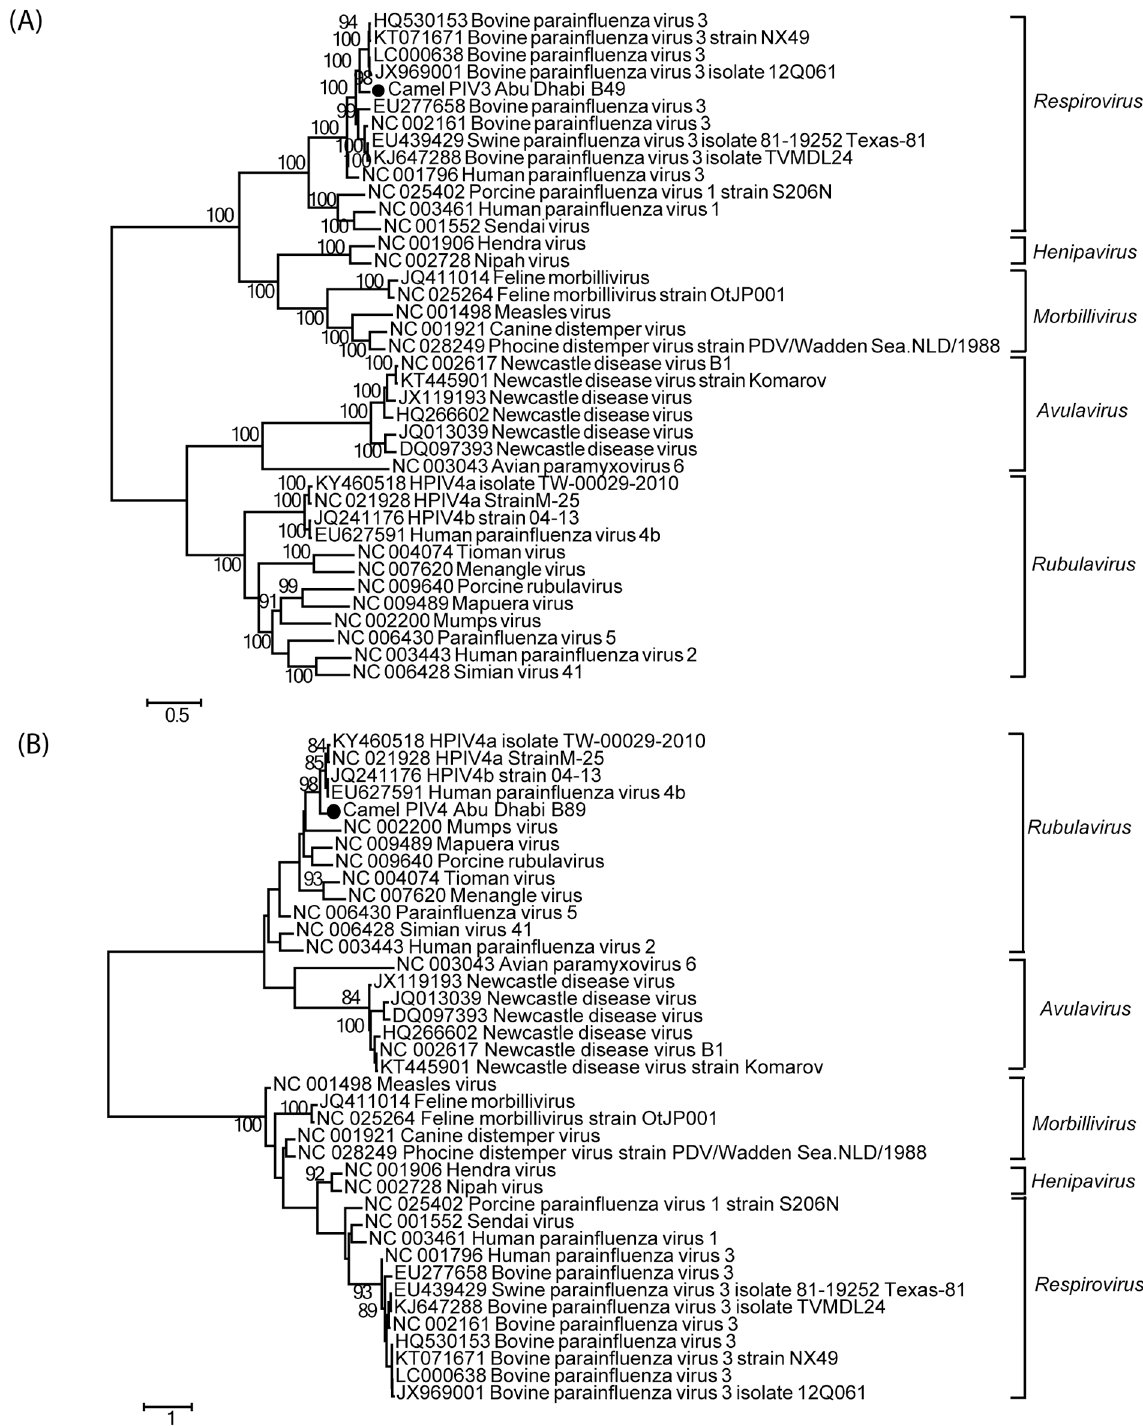
Fig 3. Phylogenetic analysis of the camel paramyxoviruses. Phylogenetic relationships are shown using maximum likelihood phylogenetic trees based on 38 paramyxovirus reference sequencesand (A) the representativecamel PIV3 Abu Dhabisequence (4575 nt in L gene), or (B) the camel PIV4 Abu Dhabi sequence(258 nt in L gene) from this study. Five generain Paramyxoviridae are labeledaccordingly. Camel virus sequencesidentified in this study are highlightedby solid circles. The scale bar indicatesthe estimated number of nt substitutions per site and the bootstrapvalues ( (cid:21) 80) are indicated.